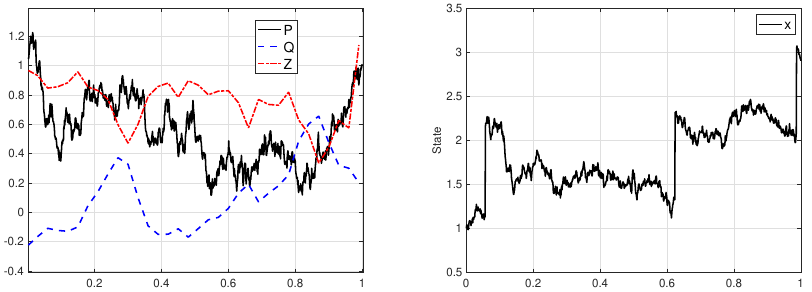
Figure 1. The simulation results of Example 2: the sample path of the ISRDE with jump diffusions in Equation (25) ( left ); the sample path of the controlled state process in Equation (23) under the optimal control in Equation (24) ( right